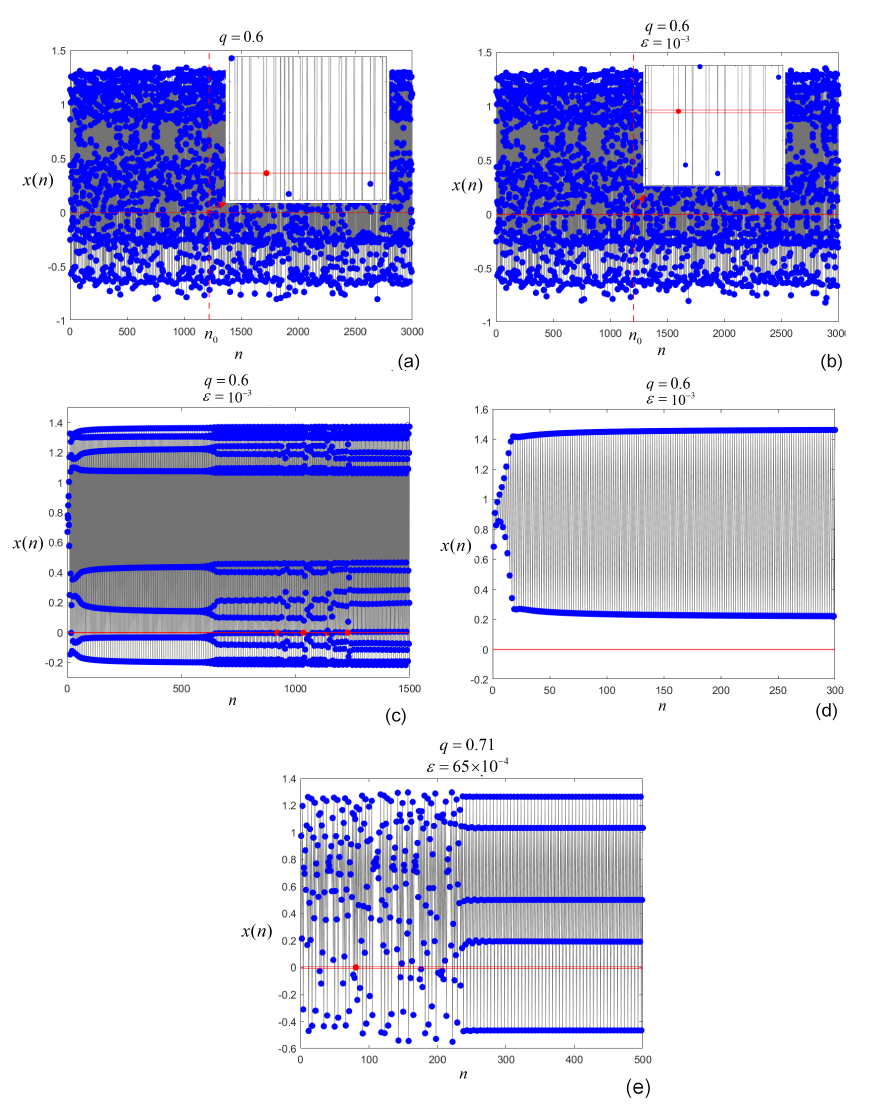
Figure 4. Orbits of the fractional systems (7) and (11); ( a ) Orbit of the fractional PWC (7) q = 0.6, m = 0.92 and p = 1.556, without approximation; ( b ) Orbit of the continuous fractional system (11) with q = 0.6, m = 0.92, p = 1.556 and ε = 10 − 3 ; ( c ) Numerically periodic orbit of the continuous fractional system (11) with q = 0.6, m = 0.92, p = 1.2 and ε = 10 − 3 situated in D + ; ( e ) Numerically periodic orbit of the continuous fractional system (11) with q = 0.7, m = 0.95, p = 1.556 and ε = 65 − 4